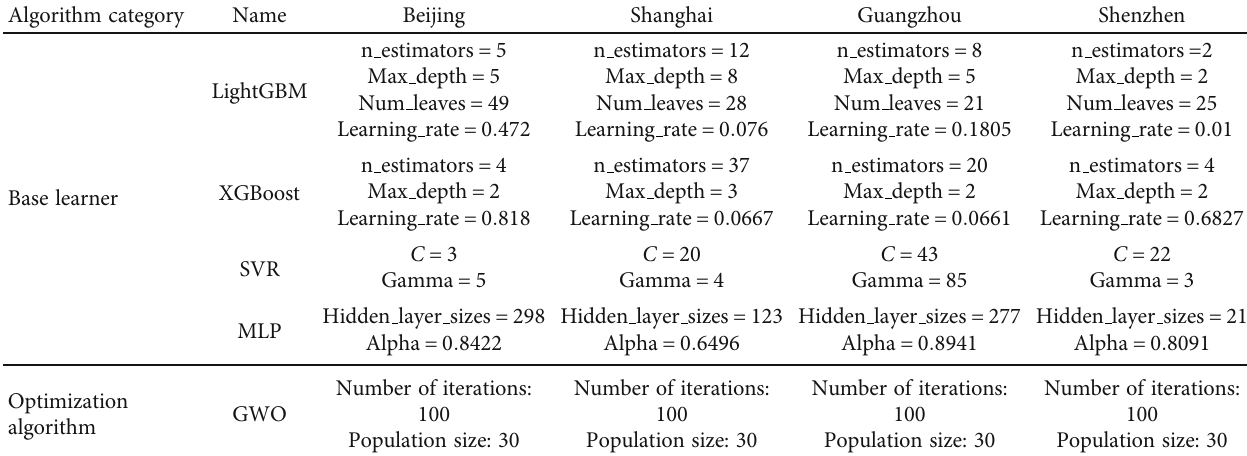
Table 3: Model parameter setting.